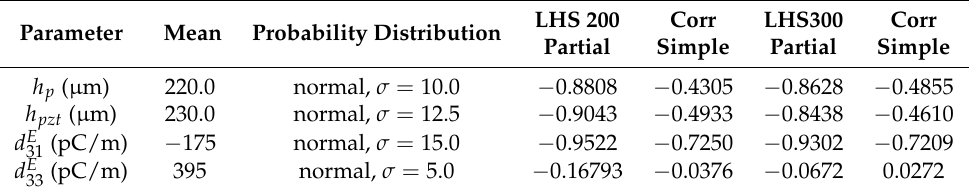
Table 7. Uncertain input parameters and correlation coefficients obtained from the Latin hypercube sampling study for maximum displacement of the APC plate. The simple and partial correlation coefficients are computed on ranked